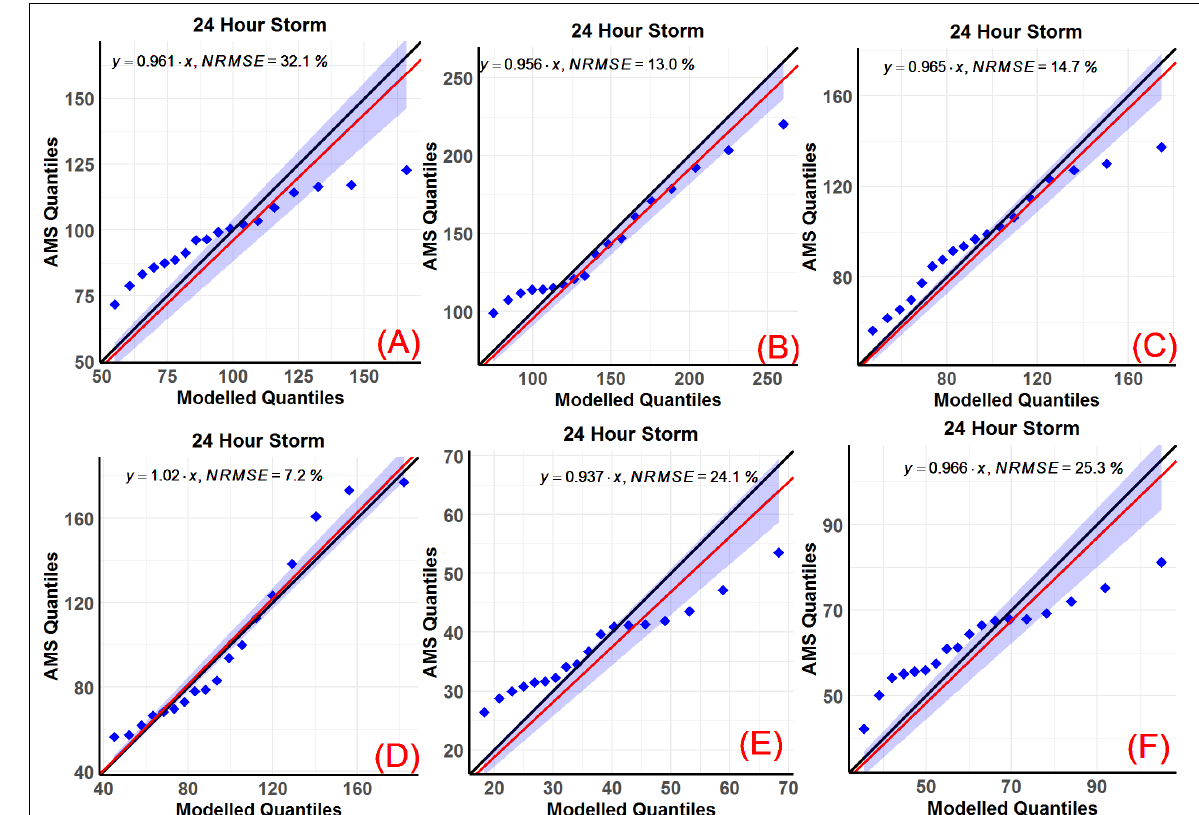
Figure 7. Q-Q plots of the AMS quantiles and Gumbel distribution with the regression line (red) and its 95% confidence computed using t-distribution for the 24-h storm duration for ( A ) Dallas-Fortworth, ( B ) Houston, ( C ) San Antonio, ( D ) McAllen, ( E ) El Paso, and ( F ) Amarillo (the quantiles used are 10%, 15%, 20%, …, 95%).